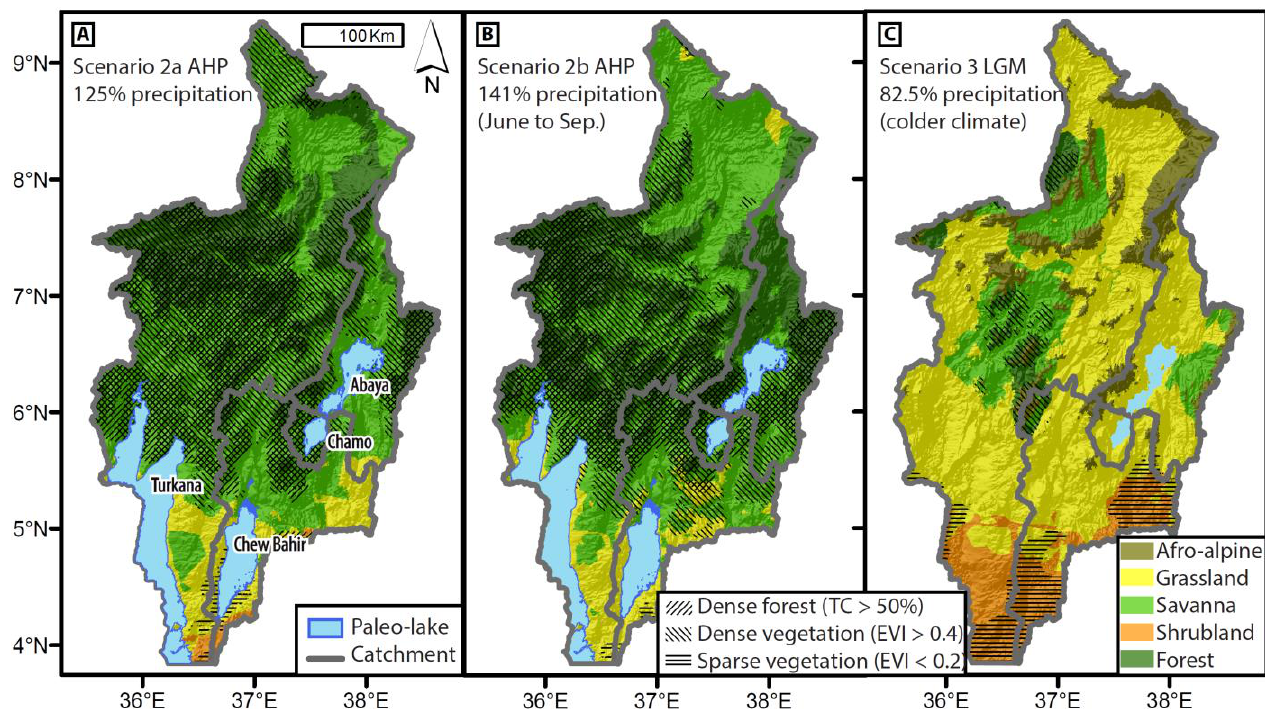
Figure 6. Model result map for scenario 2a, 2b and 3: ( A ) Scenario 2a AHP with spatial application of the LC-BRT, EVI-BRT and TC-BRT using modern-day elevation and 125% precipitation (threshold for lake appearance for scenario 2a). ( B ) Scenario 2b AHP (with CAB) with spatial application of the LC-BRT, EVI-BRT and TC-BRT using modern-day elevation and 141% increased precipitation (threshold for lake appearance for scenario 2b). ( C ) Scenario 3 LGM with spatial application of the LC-BRT, EVI-BRT and TC-BRT using elevation equivalent due to cooler temperatures and 82.5% precipitation (threshold for lake disappearance for scenario 3).